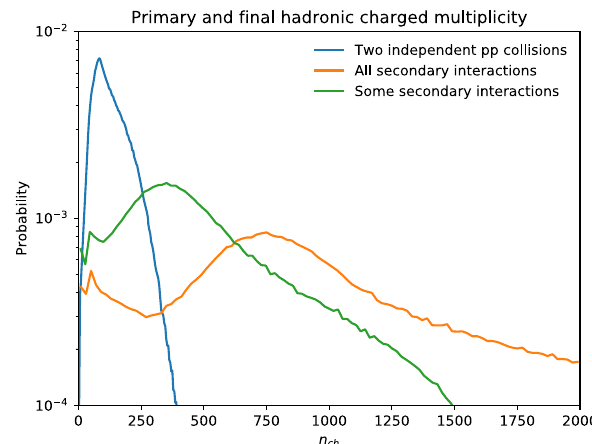
Fig. 11 Toy study on the effect of clustering nucleons into nuclei, as reflected in the charged multiplicity distribution after an initial proton has passed through two “layers” of target nucleons. In one scenario these layers are closely spaced, as inside a (nitrogen) nucleus, so that no hadrons from the first collision have time to form before the second one. Thisisapproximatedbythesumoftwoindependentppcollisions.Inthe other scenario the two “layers” are well separated, as they would be in a hydrogen atmosphere. Then all of the hadrons of the first pp collision have time to form and spread out, and each such hadron can undergo a secondindependentcollisiononatargetproton.Inonesuboption(“All”) all such hadrons are forced to undergo a second collision. In another, more realistic (“Some”), each interacts with a probability given by the ratio of the individual hadron-proton cross section to the original pp one. See further explanations in the